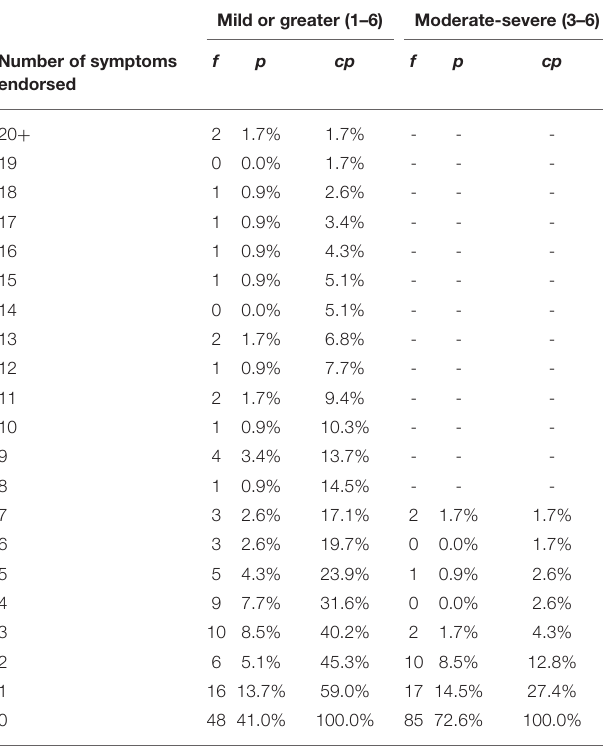
TABLE 4 | Normative reference values for baseline individual symptom endorsement.